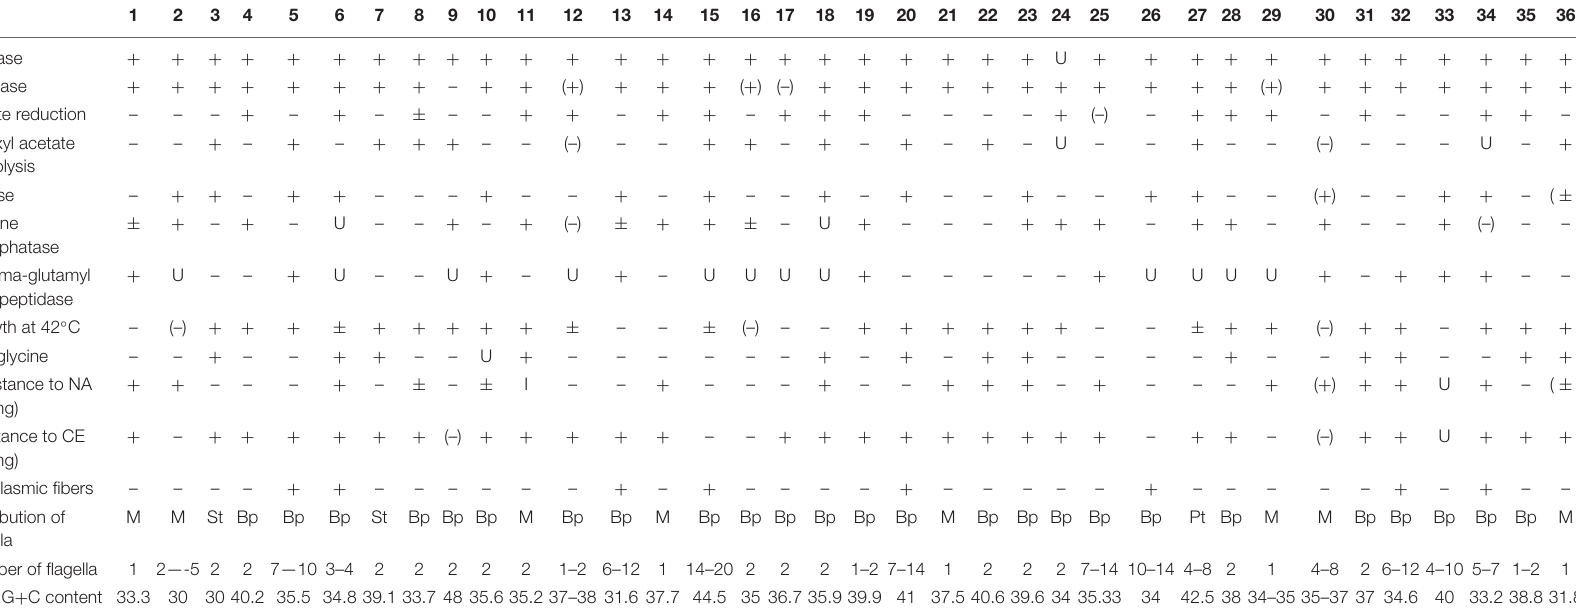
TABLE 1 | Phenotypic characteristics that differentiate H. cyclurae from other EHS and selected gastric Helicobacter species.